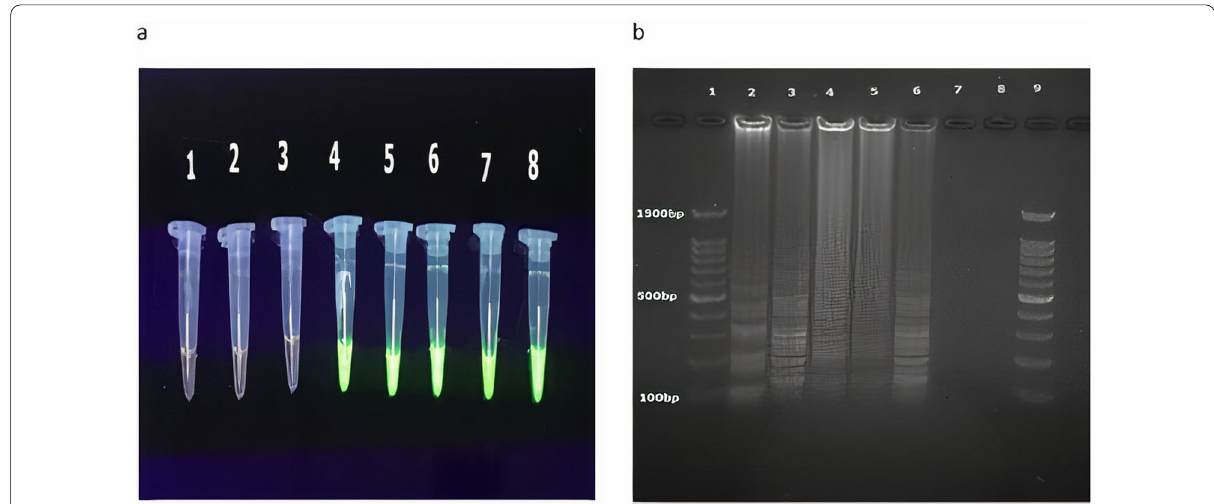
Fig. 2 Loop-mediated isothermal amplification of ctdB products: a SYBR Green-I results of loop-mediated isothermal amplification of ctdB products. Lane 1: control negative; Lane 2 and 3: negative patient samples; Lane 4–7: positive patient samples; Lane 8: Control positive: Clostridioides difficile ATCC9689; b Electrophoresis results of loop-mediated isothermal amplification of ctdB products. Lane 1 and 9: DNA ladder 100 bp; Lane 2: Control positive: Clostridioides difficile ATCC9689; Lane 3–6: Positive patient samples; Lanes 7 and 8: negative